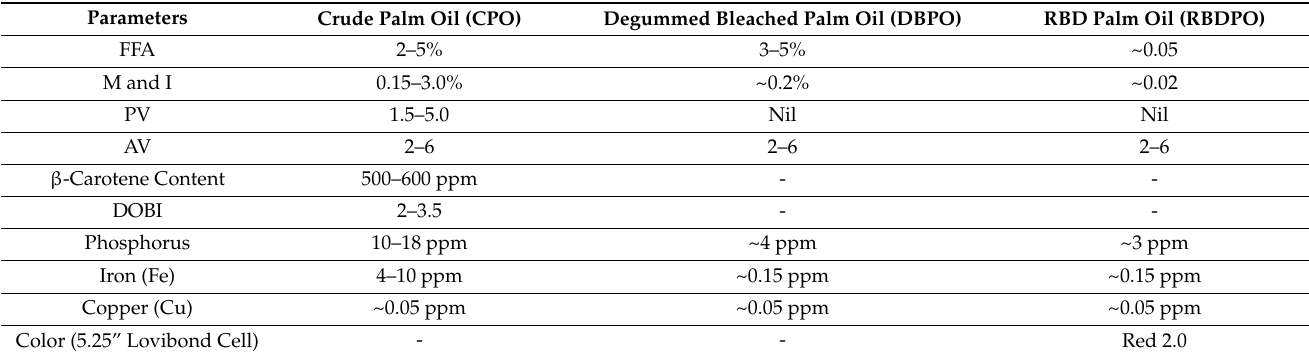
Table 4. Guideline contents for CPO, DBPO (degummed bleached) and RBDPO (refined bleached deodorized palm oil).